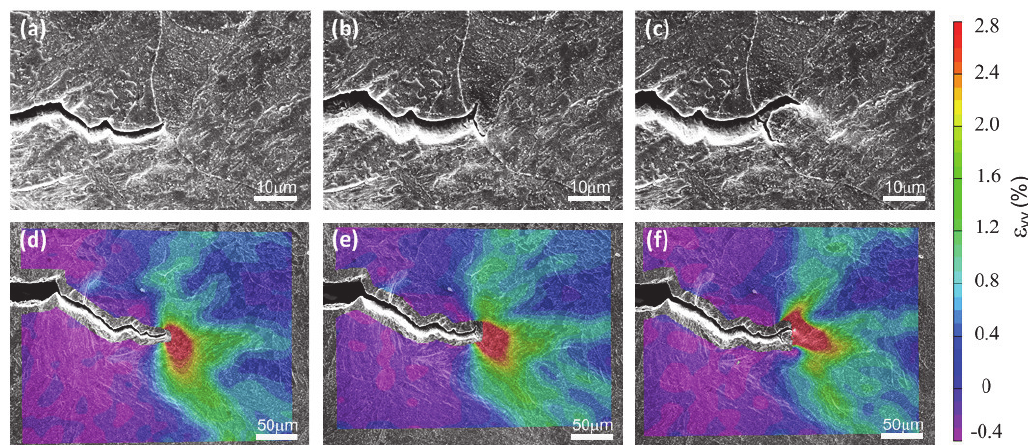
Figure 3: Crack growth morphologies during the overload process ((a), (b), and (c) are the crack tip before, at and after the overload, respectively; while (d), (e) and (f) are the corresponding strain distribution based on DIC measurement).